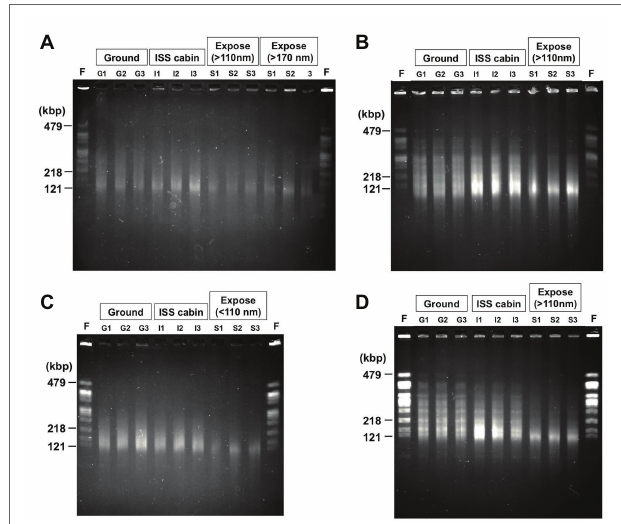
FIGURE 6 | Photo images of the pulsed field gel electrophoresis of the DNA from D. radiodurans R1 (A) , UVS78 (B) , rec30 (C) , and KH311 (D) prepared from 2.0 × 10 6 cells of the 1-year samples. Not I digested genomic DNA recovered from three different wells of aluminum plates in each condition were analyzed (Lanes G1, G2, G3 from ground controls; lanes I1, I2, I3 from ISS cabin controls; lanes S1, S2, S3 from space exposed samples). Lane F was Not I fragments of genomic chromosomal DNA prepared from freshly cultured D. radiodurans R1 2.0 × 10 6 cells. The fragment sizes (479, 218, and 121 kbp) of freshly cultured D. radiodurans R1 cells are indicated. The raw gel image files before cropping are shown in Supplementary Figure 4